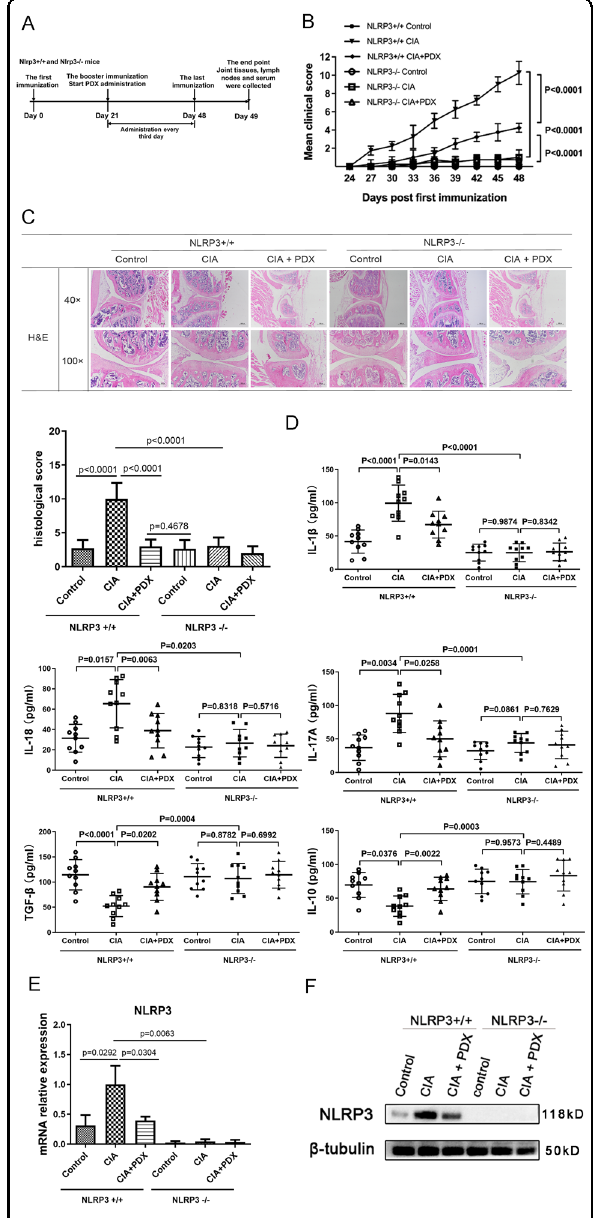
Fig. 4 Effect of PDX in alleviating in fl ammation and joint destruction in Nlrp3 − / − CIA mice. A Timeline of PDX treatment experiment in Nlrp 3 + / + and Nlrp 3 − / − mouse CIA models. B Clinical scores of PDX-treated CIA models established using Nlrp 3 + / + and Nlrp 3 − / − CIA mice. Statistical signi fi cance was de fi ned by ANOVA of repeated measurements. C H&E staining of knee joints from PDX- treated Nlrp 3 + / + and Nlrp 3 − / − CIA mice (40×, 100×) (upper panel) and histopathological analysis of H&E staining (F[3,40] = 54.02) (lower panel). D Concentrations of serum cytokines IL-1 β , IL-18, IL-17A, IL-10, and TGF- β in PDX-treated Nlrp 3 + / + and Nlrp 3 − / − CIA mice as shown by ELISA. E Expression of NLRP3 mRNA in lymphocytes from PDX- treated Nlrp 3 + / + and Nlrp 3 − / − CIA mice as shown by RT-qPCR (F[6,18] = 18.62). F NLRP3 protein levels in lymph nodes of PDX-treated Nlrp 3 + / + and Nlrp 3 − / − CIA mice as shown by